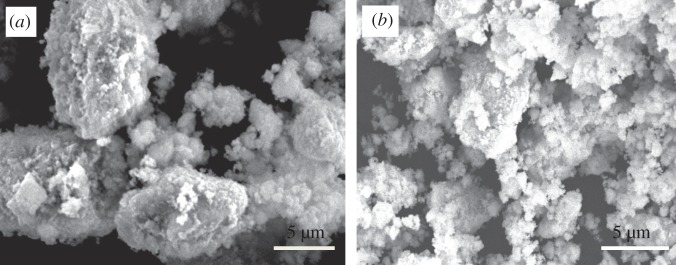
SEM micrograph of 18 h-milled powders; (a) (CuO)0.8(CeO2)0.2 and (b) (CuO)0.2(CeO2)0.8.